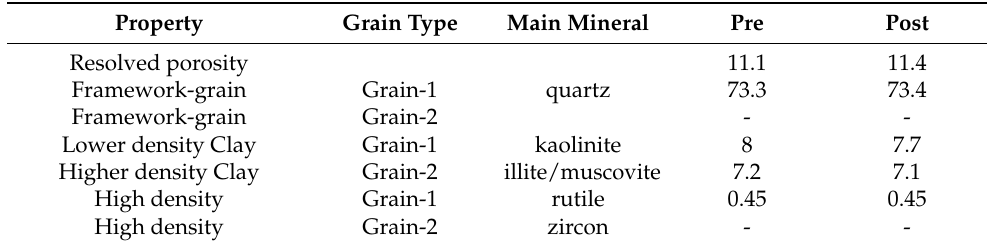
Table 2. Pre- and post-reaction volume% of X-ray distinct components from segmentation of the sub-plug. The main mineral corresponding to the grain type is also